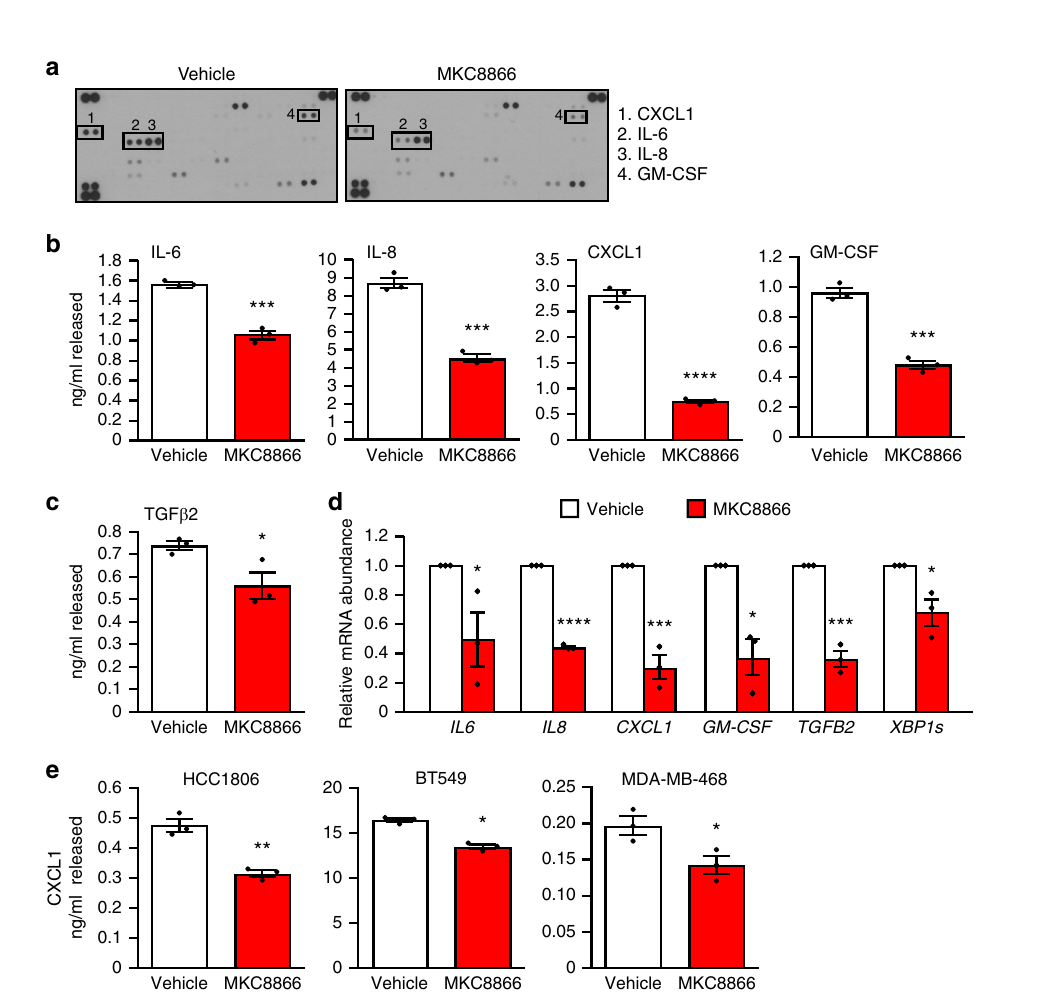
Fig. 4 IRE1 activity induces production of pro-in fl ammatory factors. a – d MDA-MB-231 cells cultured in medium containing 2% serum were treated with 20 μ M MKC8866 or vehicle alone for 48 h after which cells and conditioned medium were collected. a Conditioned medium was applied to a Human XL Cytokine Array. Expression pro fi le of cytokines in vehicle alone versus MKC8866-conditioned medium was determined by chemiluminescence. b , c Cytokine secretion was quanti fi ed in conditioned medium using ELISAs selective for IL-6, IL-8, CXCL1, GM-CSF, and TGF β 2 ( n = 3). d mRNA transcript levels of IL6 , IL8 , CXCL1 , GM-CSF , TGFB2 , and XBP1s were quanti fi ed by Q-PCR ( n = 3). e CXCL1 quanti fi cation in conditioned medium collected from HCC1806, BT549, and MDA-MB-468 cells treated for 48 h in 2% serum-containing medium supplemented with vehicle alone or 20 μ M MKC8866 ( n = 3). Results shown for a are representative of two independent experiments. * P < 0.05, ** P < 0.01, *** P < 0.001 and **** P < 0.0001, based on a Student ’ s t test. Error bars represent s.e.m.